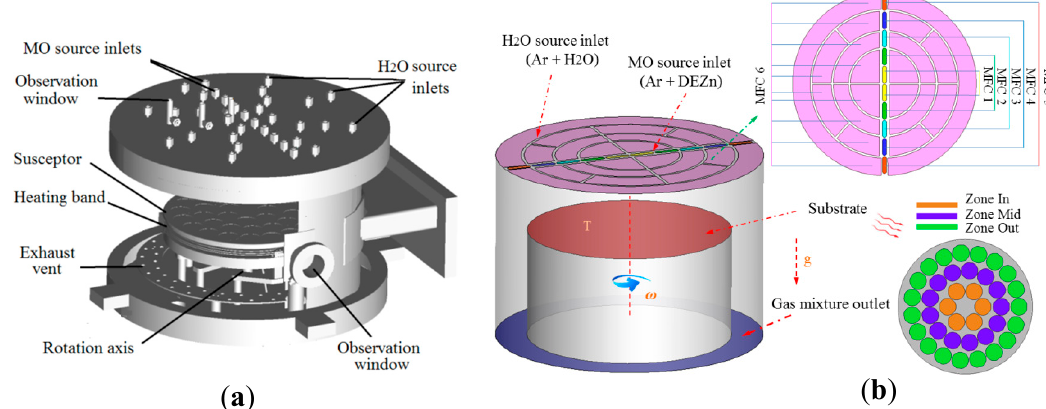
Figure 1. ( a ) 3D model diagram of the reaction chamber for the zinc oxide-metal-organic chemical vapor deposition (ZnO-MOCVD) prototype; ( b ) computational fluid dynamics simulation of the ZnO-MOCVD model and wafer distribution of the substrate surface.